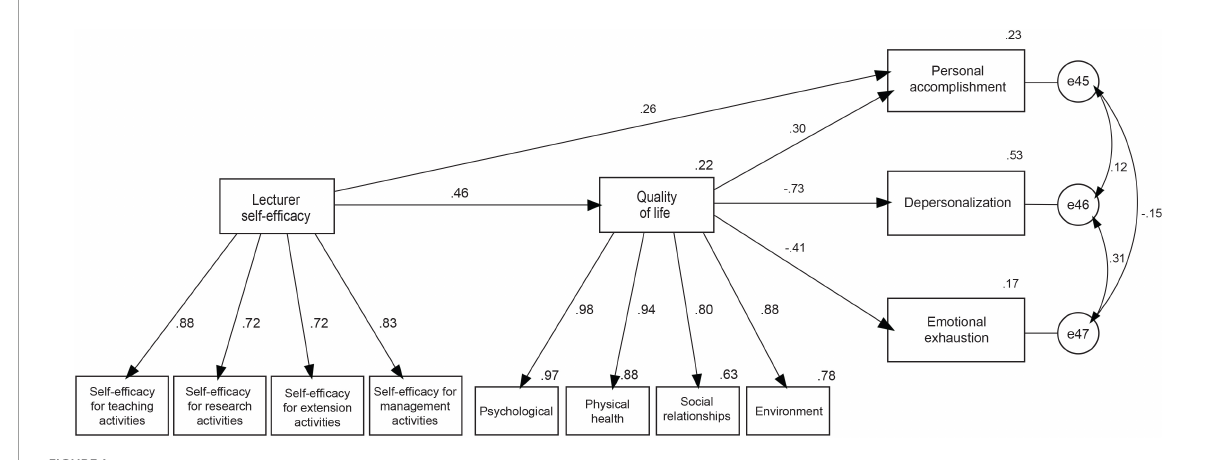
FIGURE1 Structural model of lecturer self-efficacy, quality of life and burnout. Standardized values reported. All values significant at p < 0.001.